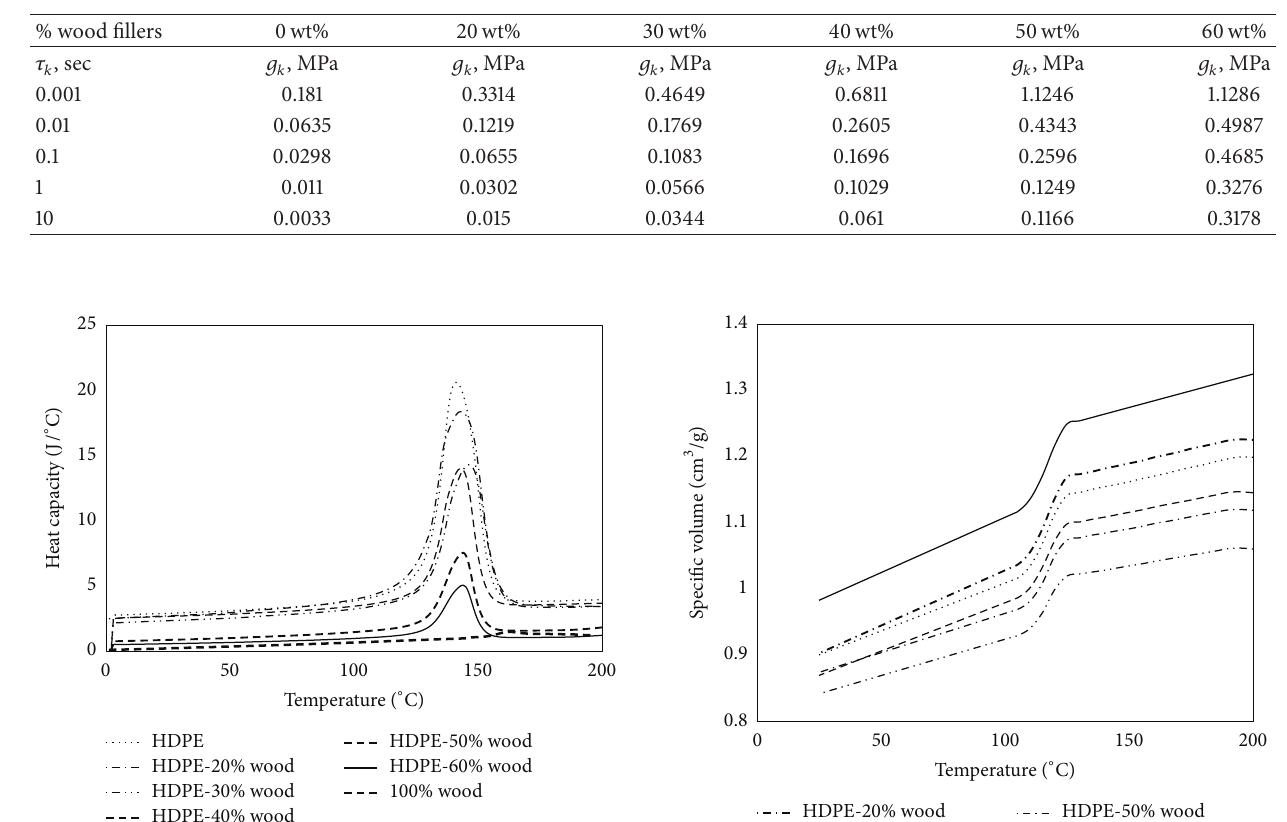
Table 2: Relaxation spectrum at 170 ∘ C for WPC.